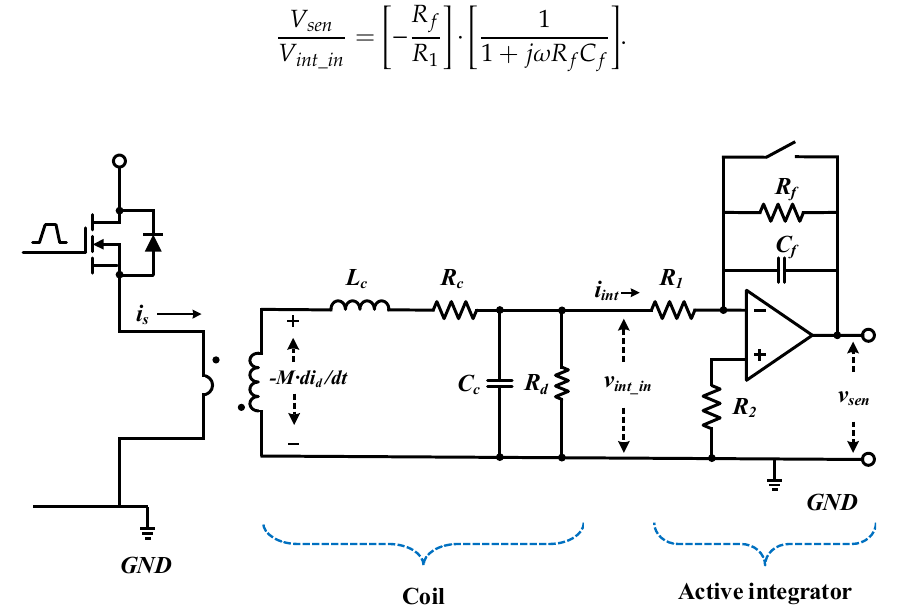
Figure 4. Comprehensive equivalent circuit sensor.